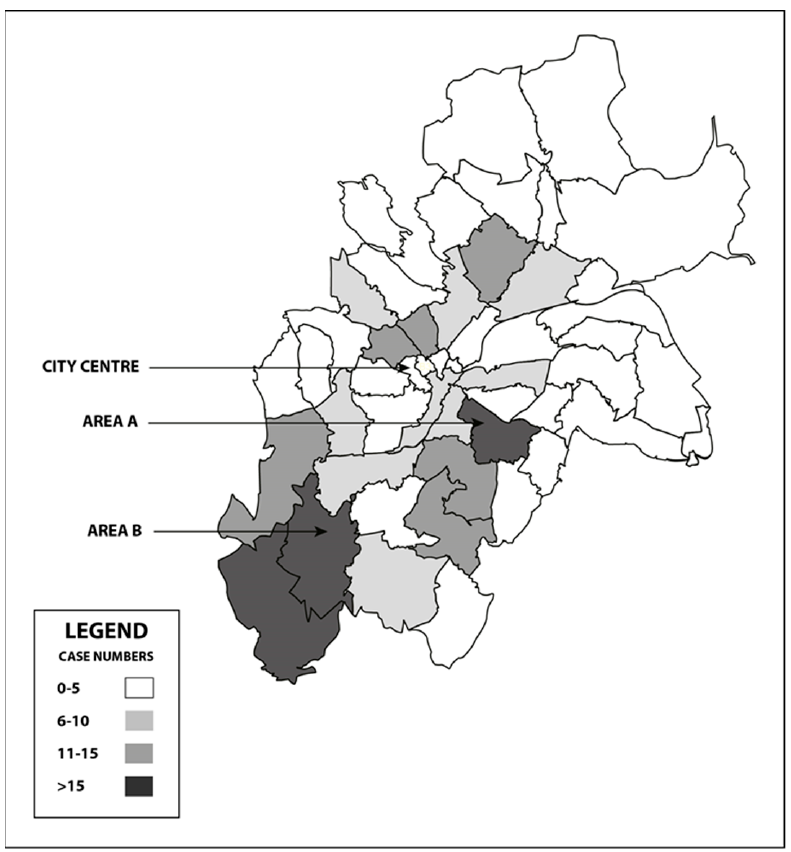
Figure 3. Distribution of cases within Birmingham Postcode areas.